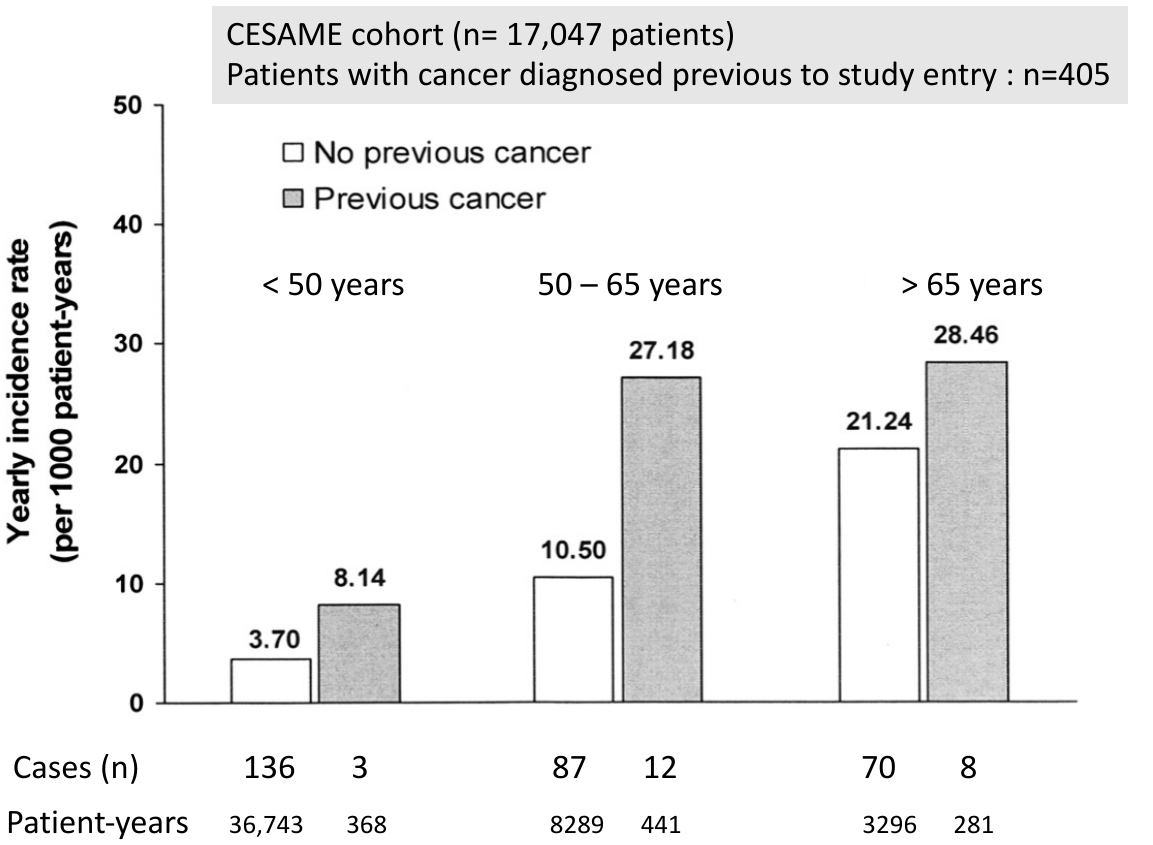
Figure 2. Annual incidence rate of cancer in IBD patients with and without previous cancer